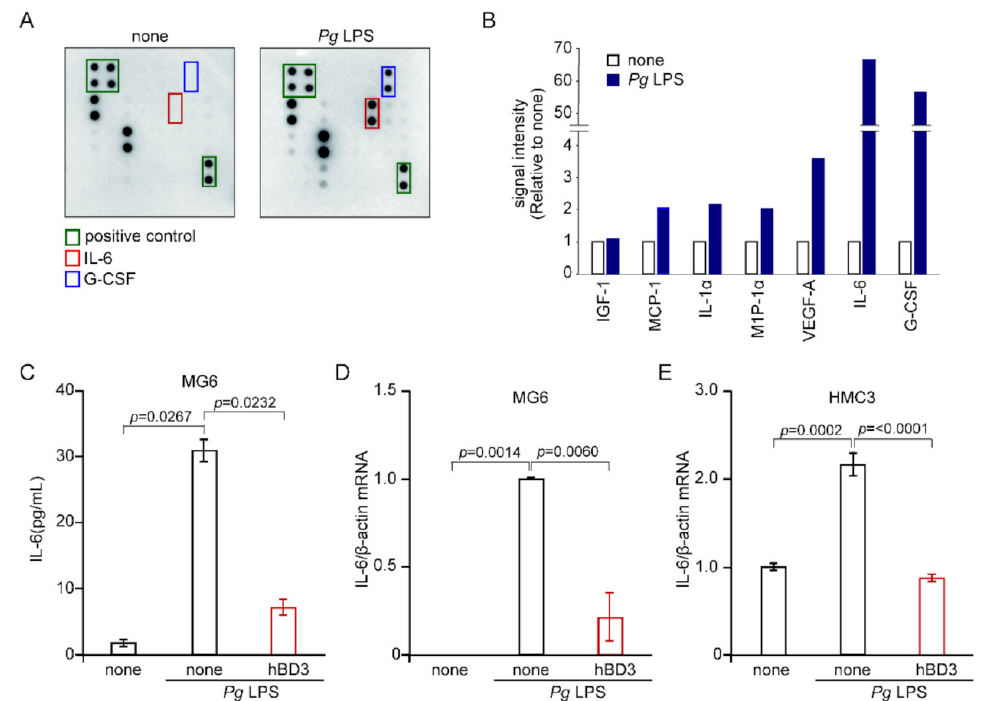
Figure 2. Effects of hBDs on the cytokine expression by microglia after exposure to Pg LPS. ( A ) Cytokines secreted from MG6 cells after exposure to Pg LPS were detected by cytokine antibody array. Each cytokine is represented by duplicate spots in the locations shown. ( B ) Densitometric analyses of cytokine spots shown in A. Each column represents fold change of optical intensity for average of two spots detected. ( C ) The mean protein level of IL-6 secreted in the culture medium of MG6 cells was determined by ELISA. MG6 cells were pre-treated with hBD3 (1 µ M) for 2 h and then treated with Pg LPS (10 µ g/mL) for 6 h. ( D ) The mean mRNA expression level of IL-6 in MG6 cells was determined by qRT-PCR analysis and β -actin mRNA served as the internal control for the normalization. MG6 cells were pre-treated with hBD3 (1 µ M) for 2 h and then treated with Pg LPS (10 µ g/mL) for 6 h. ( E ) The mean mRNA expression level of IL-6 in HMC3 cells was determined by qRT-PCR analysis and β -actin mRNA served as the internal control for the normalization. HMC3 cells were pre-treated with hBD3 (1 µ M) for 2 h and then treated with Pg LPS (30 µ g/mL) for 3 h. ( C – E ) The data are presented as the mean ± SE of three independent experiments, and p values were calculated using a one-way ANOVA with a post-hoc Tukey’s test. A value of p < 0.05 was considered to indicate statistical